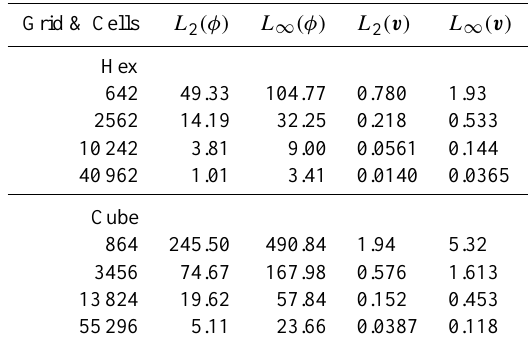
Table 6. Geopotential errors (m 2 s − 2 ) and velocity errors (m s − 1 ) at day 5 for the solid body rotation test